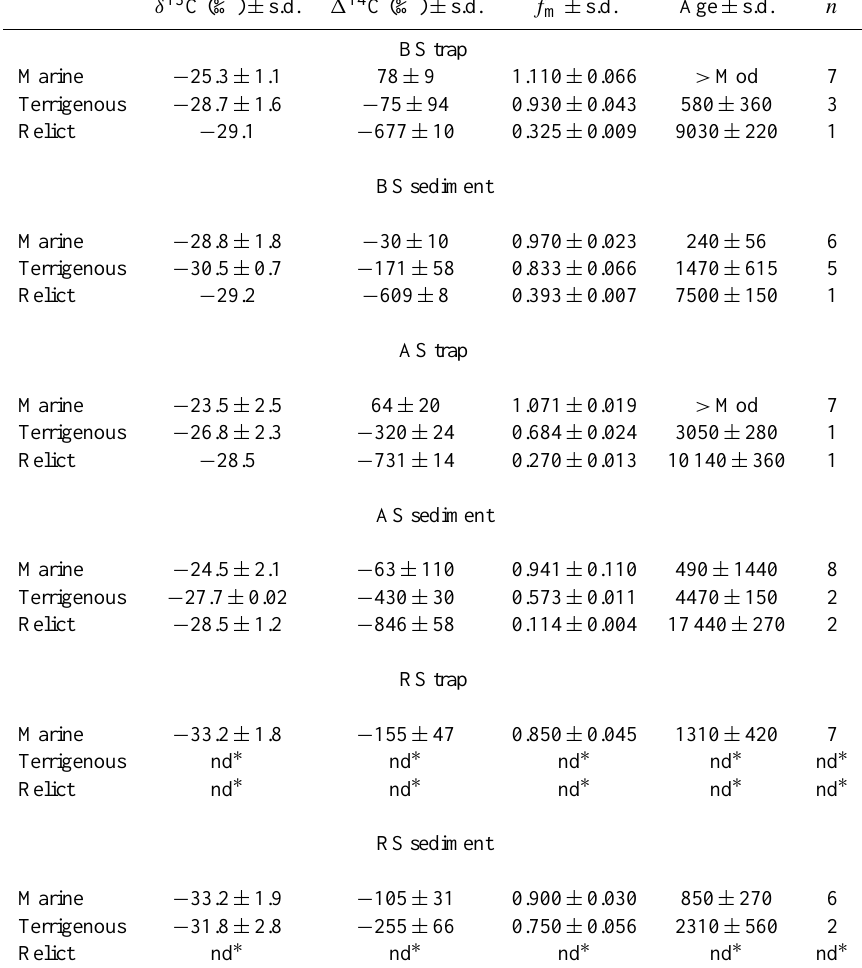
Table 4. Abundance-weighted mean table carbon and radiocarbon isotope values for composited marine, terrigenous and relict biomarkers. δ 13 C (‰) ± s.d. (cid:49) 14 C (‰) ± s.d. f m ±